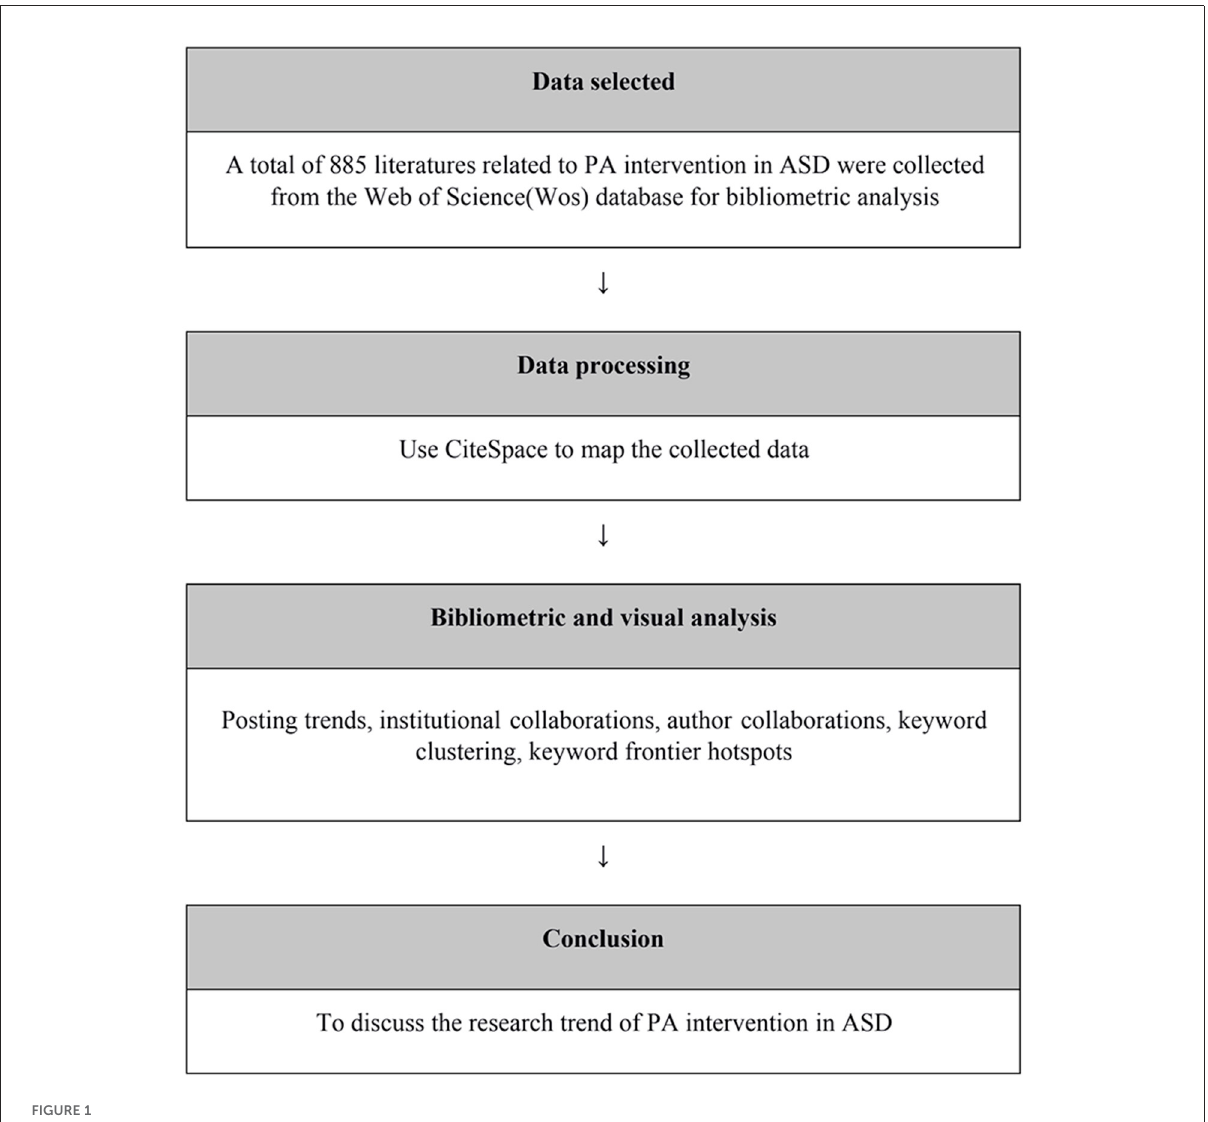
FIGURE1 Process